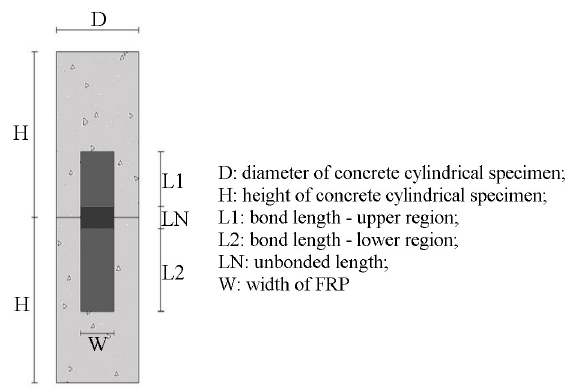
Figure 1. Specimen and FRP regions